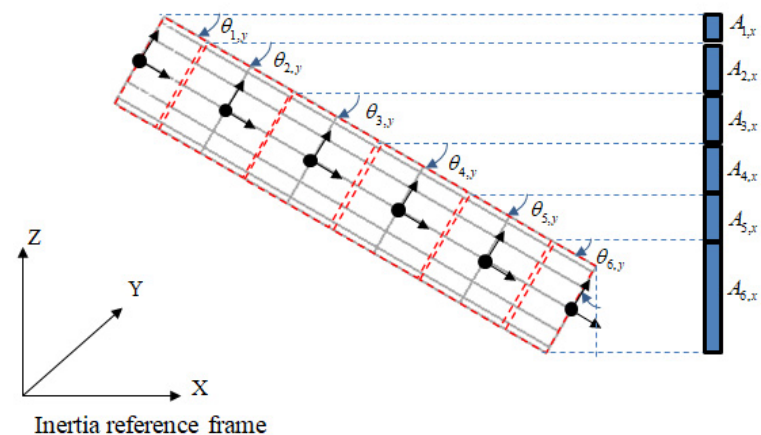
Figure 7. A method of calculating the area of drag force acting on a riser.